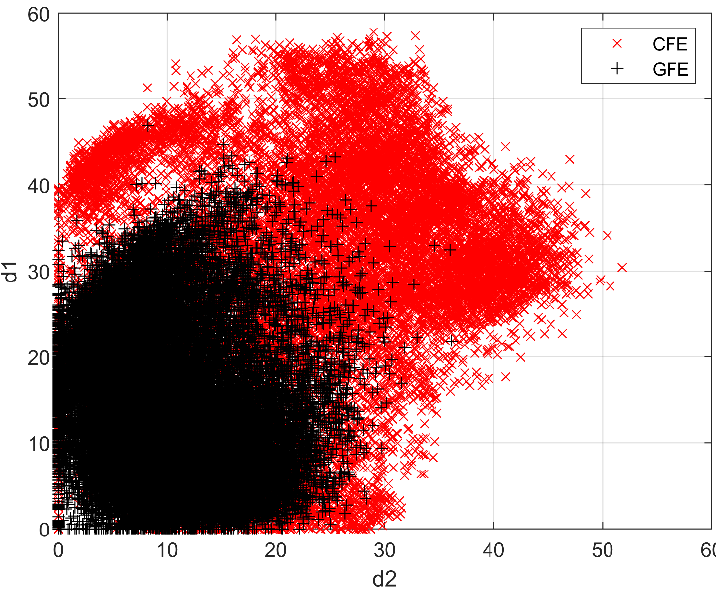
Figure 6. The representation of CFG and GFC samples in the space of the two most relevant features (d1 and d2).